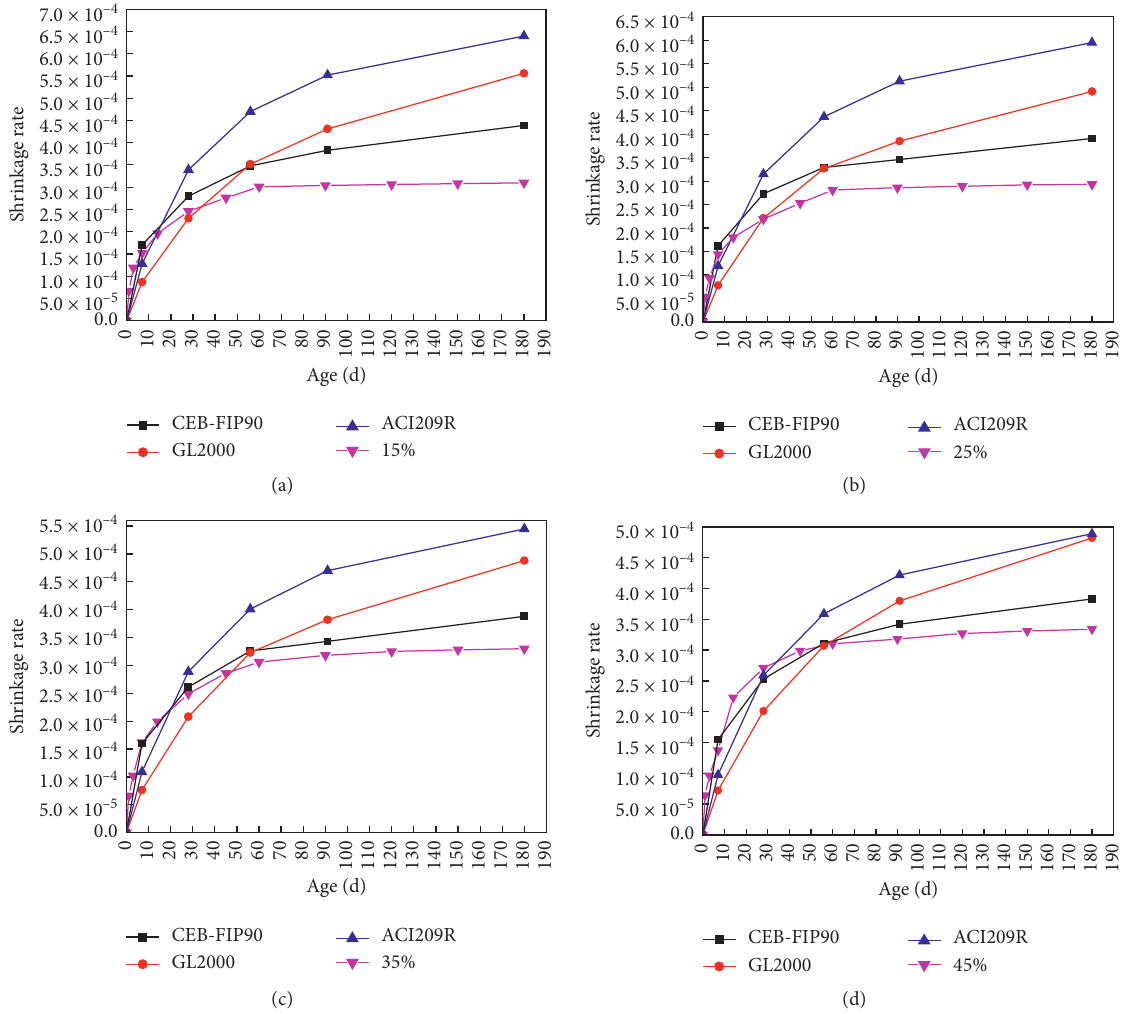
Figure 9: Comparison among the predicted concrete shrinkage values from the CEB-FIP 90, ACI 209R, and GL 2000 models and the observed concrete shrinkage values obtained during this study’s experimentation: (a) 15% fly ash; (b) 25% fly ash; (c) 35% fly ash; (d) 45% fly